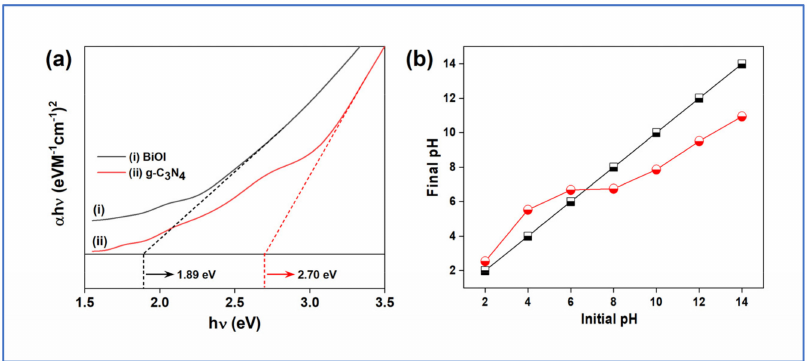
Figure 3. ( a ) Tauc plot; ( b ) pH point of zero charge for GA-cl-poly(acrylamide)@ C 3 N 4 /BiOI nanocom- posite